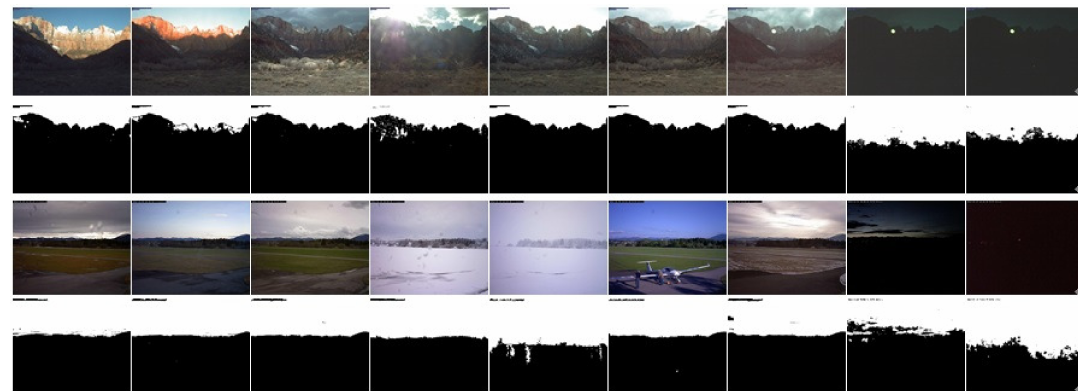
Figure 8. Our sky detection results on the SkyFinder dataset. We selected a number of images captured in different weather and lighting conditions from 4 cameras. The odd rows show the input images, and the even rows are the corresponding sky detection